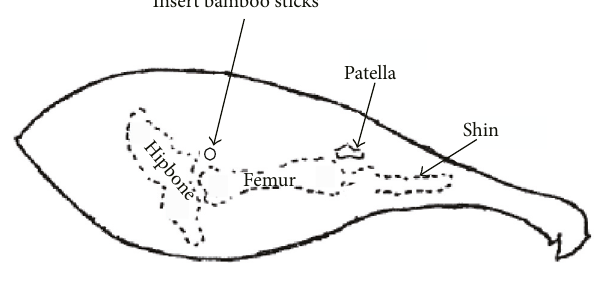
Figure 1: Information of insert of the bamboo